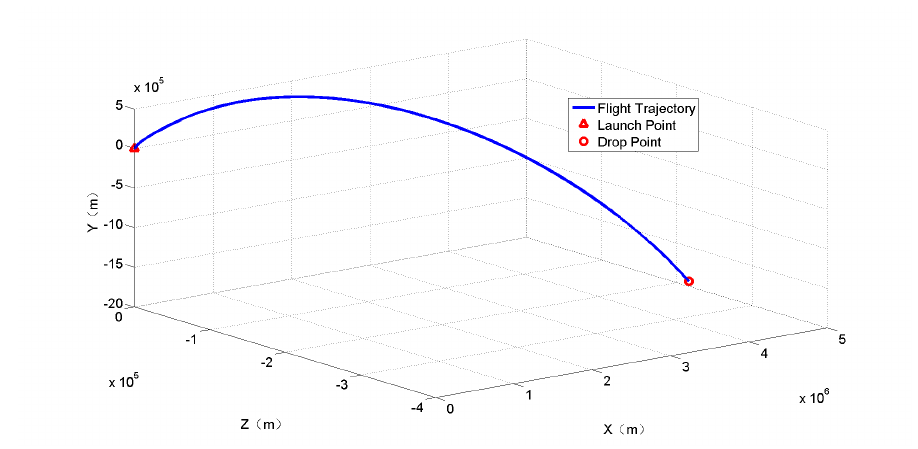
Figure 5. Missile flight